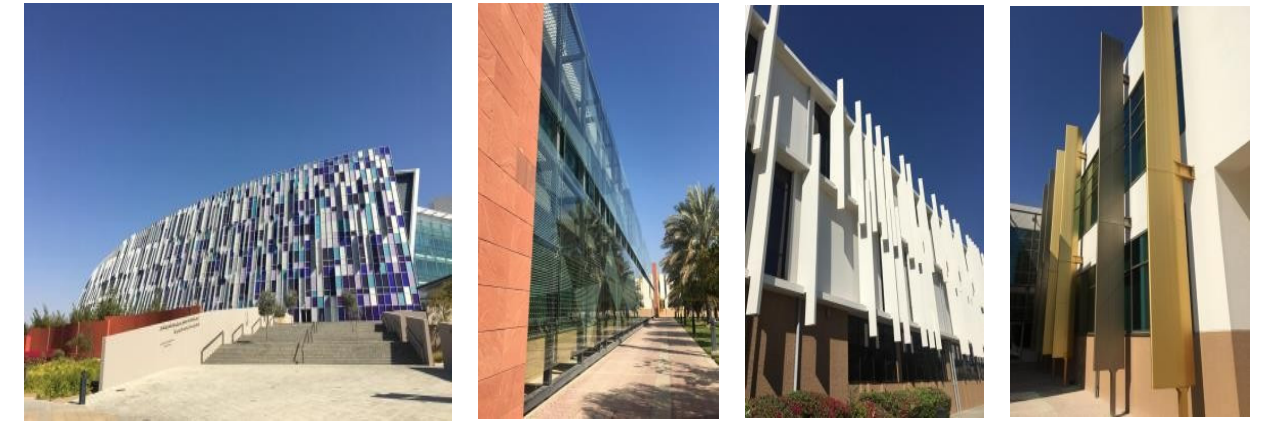
Figure 4. Site images from UAEU campus.